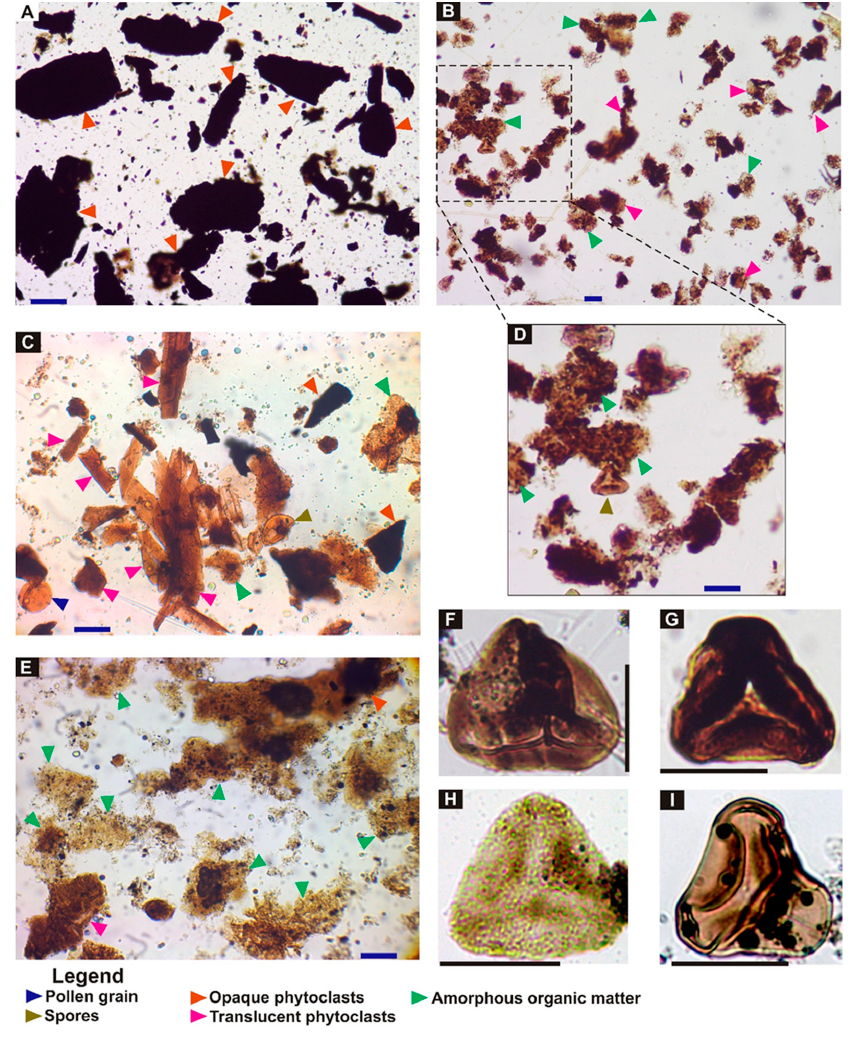
Figure 5. Photomicrographs of the recovered POM and spores from the Khatatba Formation taken under transmi tt ed white light. The corresponding well name, sample depth, slide number, and co- ordinates of the species in the kerogen slides are given. The scale bar is equivalent to 40 µm. ( A ) POM composition of PFA-1 with high proportions of opaque phytoclast fragments in the Falak-21 well, 3905 m, slide 1; ( B ) POM composition of PFA-2 with moderate proportions of AOM and phy- toclasts in the OBA D-17 well, 4000 m, slide 1; ( C ) POM composition of PFA-3 with moderate pro-